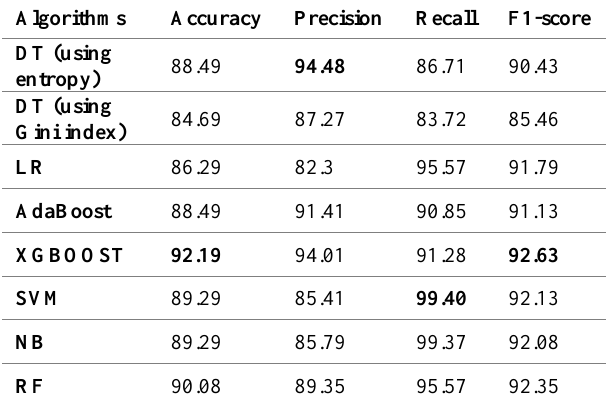
Table 5 . Evaluation results of each model for stopping